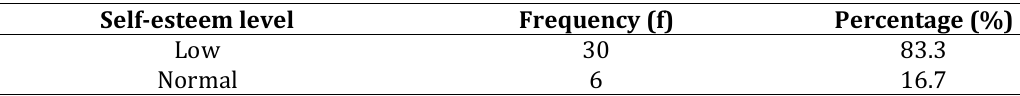
Level of self-esteem before life-review therapy